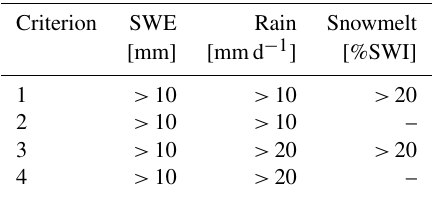
Table 2. Four alternative pixel-based criteria for ROS events.